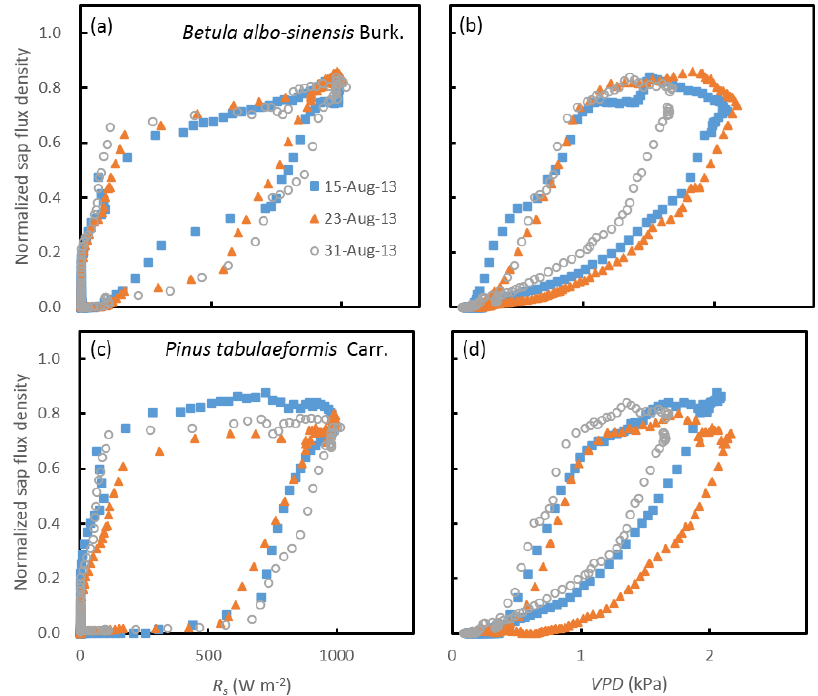
Figure 4. The diurnal hysteresis of the normalized F d ‐ R s ( a ), ( c ) and the normalized F d ‐ VPD ( b ), ( d ) for B. albosinensis (upper row) and P. tabuliformis (lower row) on three typical days—i.e., two pre ‐ rainfall days with different soil ‐ water contents, 15 and 23 August, and a post ‐ rainfall day on 31 August. On 28 August, a heavy rainfall event occurred (22.8 mm). Note that the normalized F d ‐ R s hysteresis was counter ‐ clockwise and the normalized F d ‐ VPD hysteresis was clockwise. Each dot represents the normalized sap flux density converted from the sap flux density averaged from all probes for each species. F d , Sap flux density.